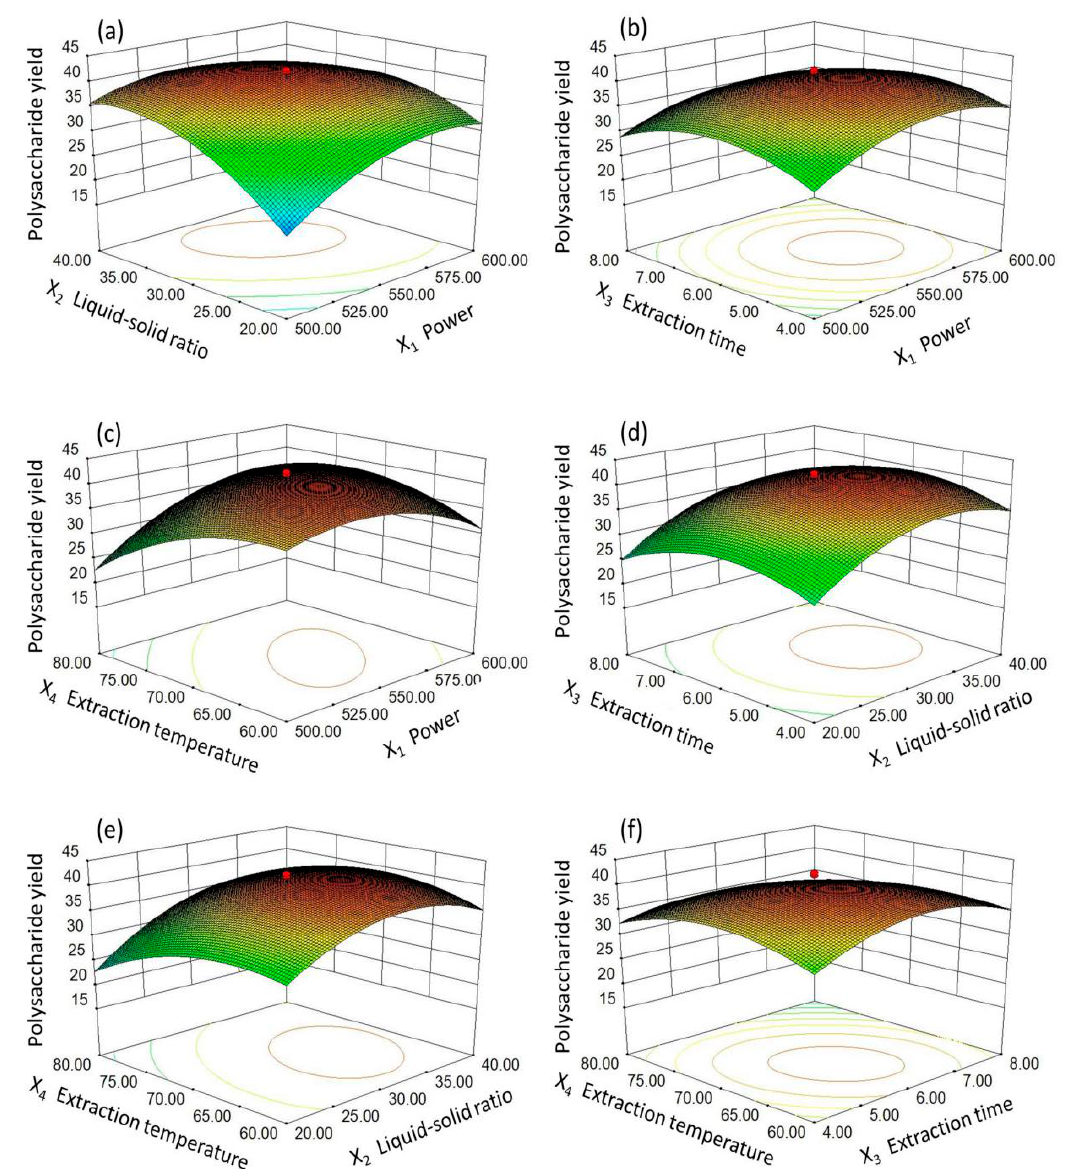
Figure 2. Response surface plots (3D) for the microwave-assisted extraction of MPPG. ( a ) Liquid-to-solid ratio versus microwave power; ( b ) Extraction time versus microwave power; ( c ) Extraction temperature versus microwave power; ( d ) Liquid-to-solid ratio versus extraction time; ( e ) Extraction temperature versus liquid-to-solid ratio; and ( f ) Extraction temperature versus extraction time.